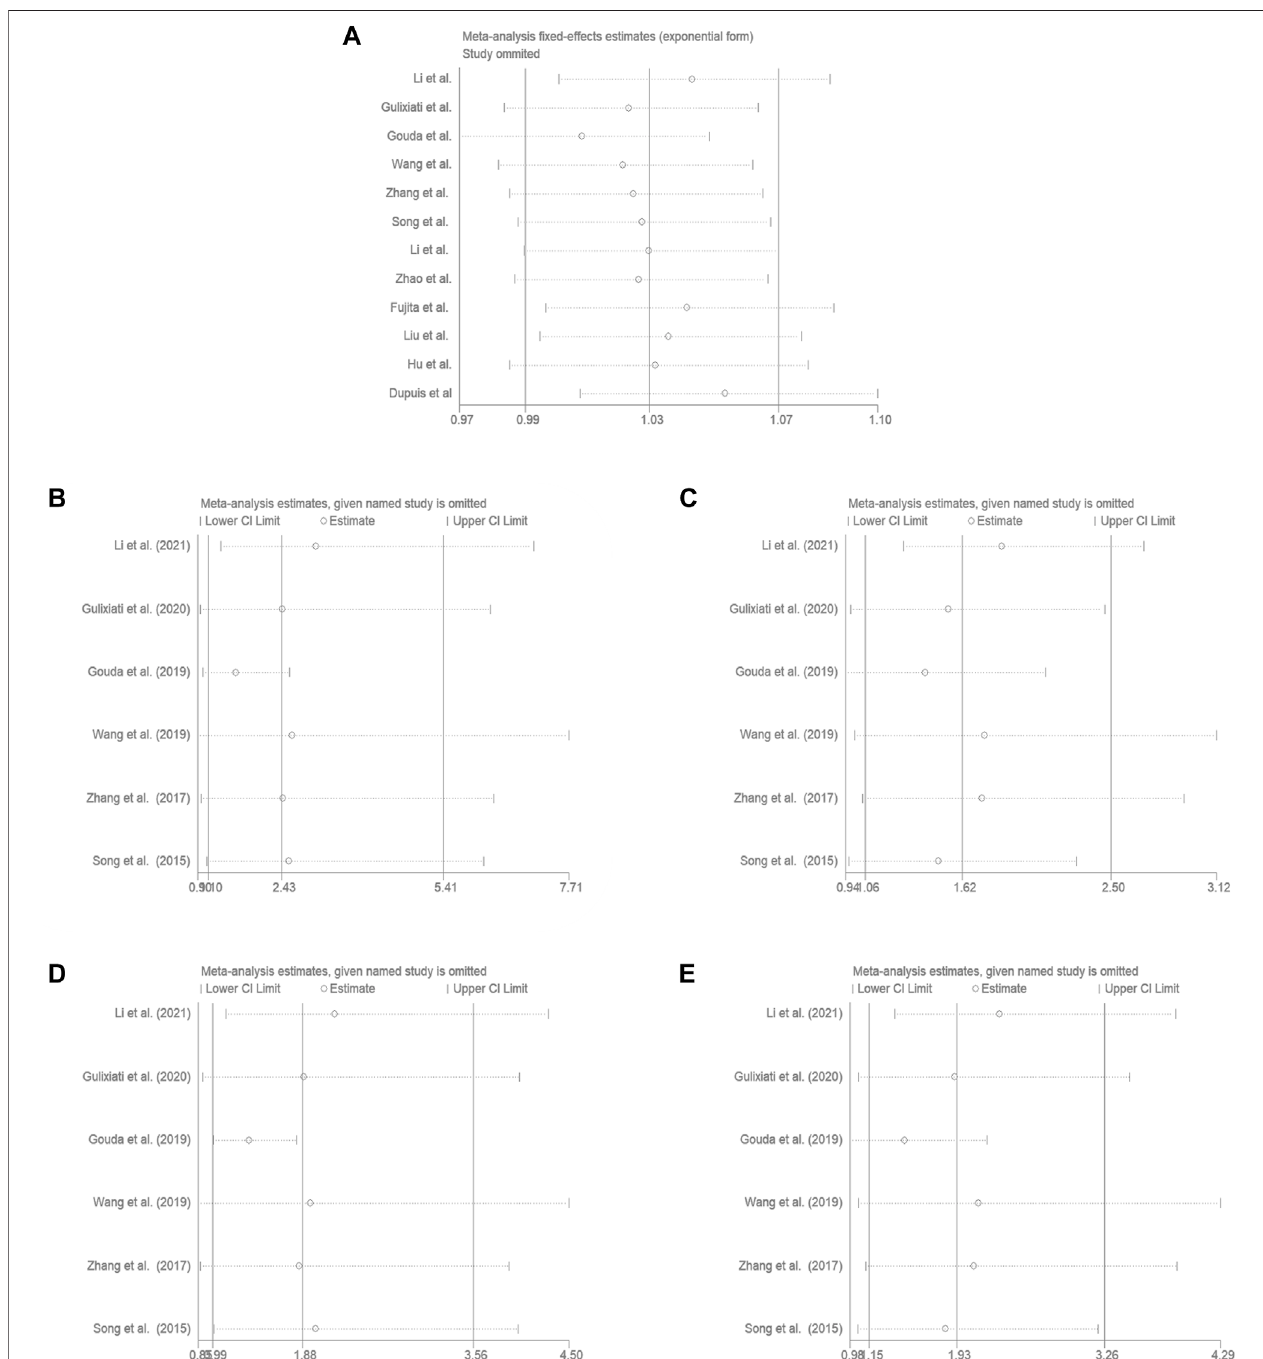
FIGURE 3 | Sensitivity analysis by iteratively removing one study at a time. (A) Allele model, T vs. C. (B) Additive model (homozygote comparisons): TT vs. CC. (C) Additive model (heterozygote comparisons): TC vs. CC. (D) Recessive model, TT vs. CC + CT. (E) Dominant model, TT + CT vs. CC.